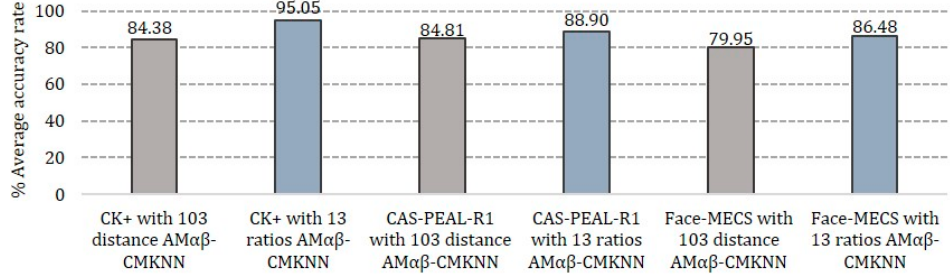
Figure 14. Results of the 10 test rounds of the k-fold-cross validation method applied during the test phase of Experiments 1 and 2 using the CK+, CAS-PEAL-R1 and Face-MECS databases.